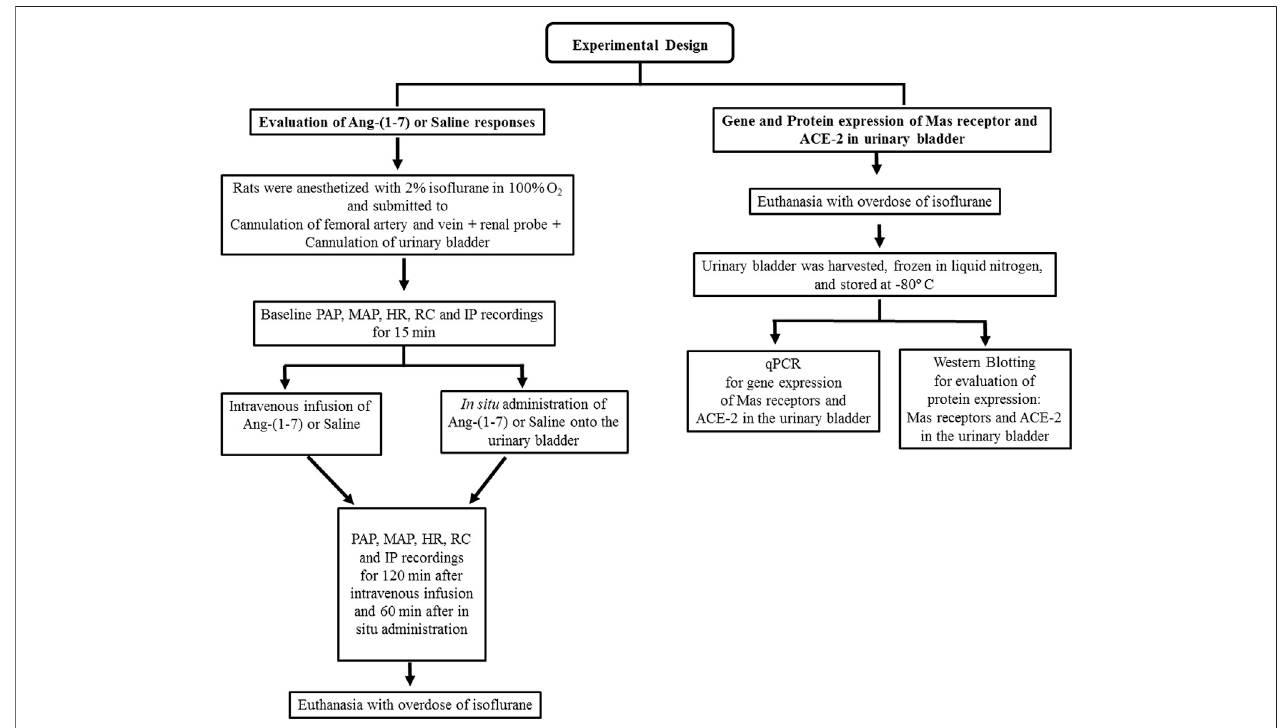
FIGURE 1 | Flowchart showing the experimental design of the